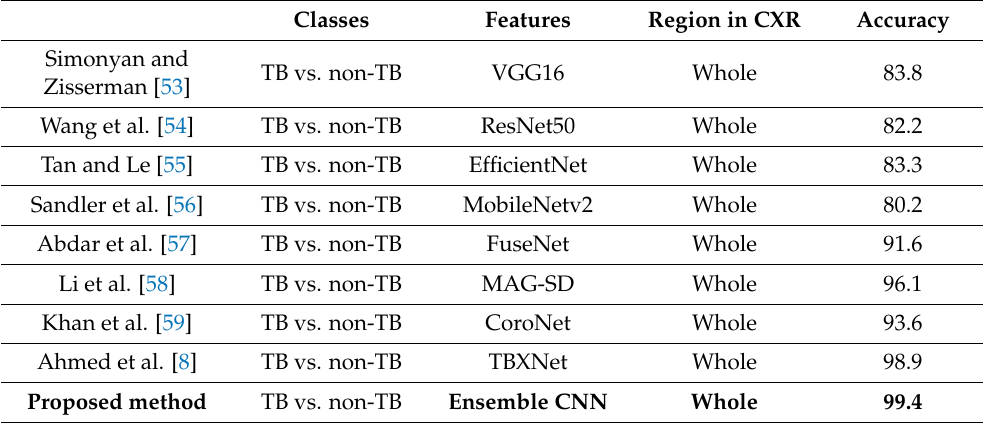
Table 5. The accuracy of the proposed methods with the existing heuristics to classify TB and Non-TB (Dataset A).